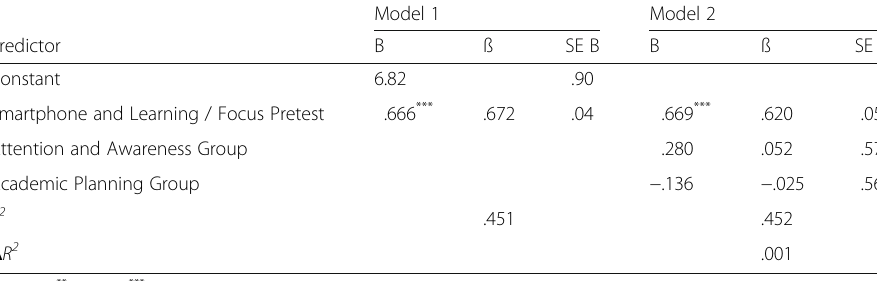
Table 5 Limited smartphone usage while studying post intervention Model 1 Model 2